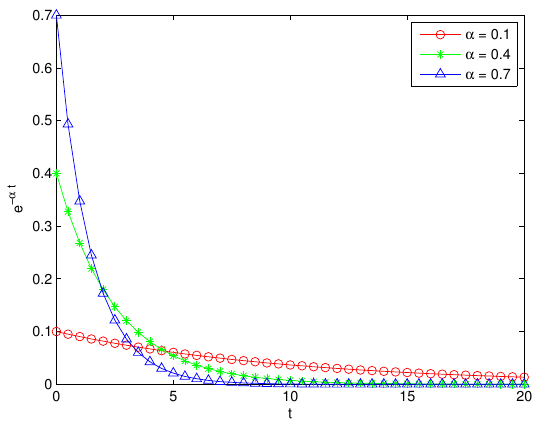
Figure 3. Trends of α × e − α · t for different α